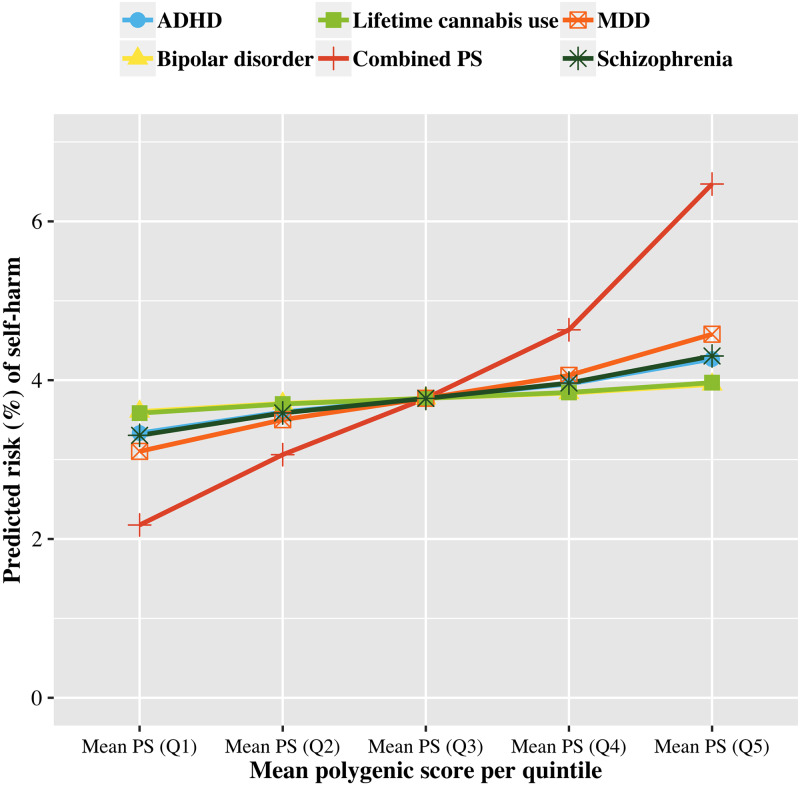
Predicted risk of self-harm for each of the 5 significantly predictive PSs and their combined predicted risk.Plot of the independently predicted risk of self-harm for each of the 5 significantly predictive PSs (for ADHD, bipolar disorder, lifetime cannabis use, MDD, and schizophrenia) and their combined predicted risk obtained from multivariate logistic regression. For independent prediction using a single PS, the mean of that particular PS in each quintile was used as predictor while the values of other PSs were set to 0 (i.e., the centred mean). For combined prediction, for each quintile, 5 mean values of the PS (mean PS for ADHD, bipolar disorder, lifetime cannabis use, MDD, and schizophrenia) were entered simultaneously as predictors. ADHD, attention deficit/hyperactivity disorder; MDD, major depressive disorder; PS, polygenic score.